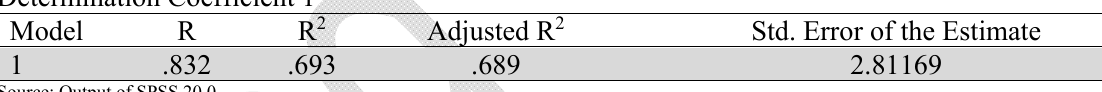
Determination Coefficient 1 Model R R 2 Adjusted R 2 Std. Error of the Estimate